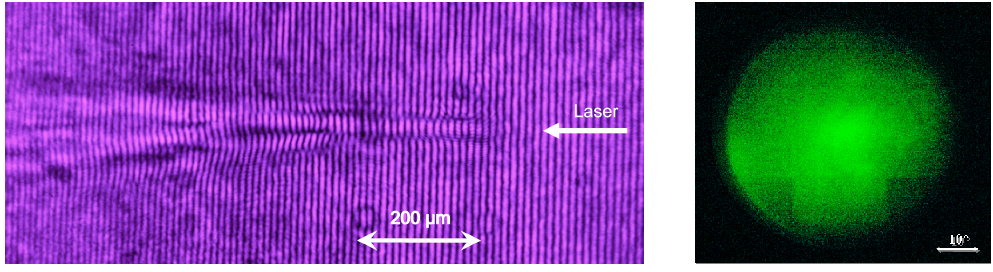
Figure 1. Left: Interferogram of the gas-jet interaction region taken 2 ps after propagation of the laser pulse. The shot was taken in N at a backing pressure of 35 bar, with the laser focal 2 plane located 50 µ m into the gas-jet and 400 µ m from the nozzle output plane. Right: typical outputs of LANEX showing moderately collimated laser-accelerated electrons in case of N gas @ 50